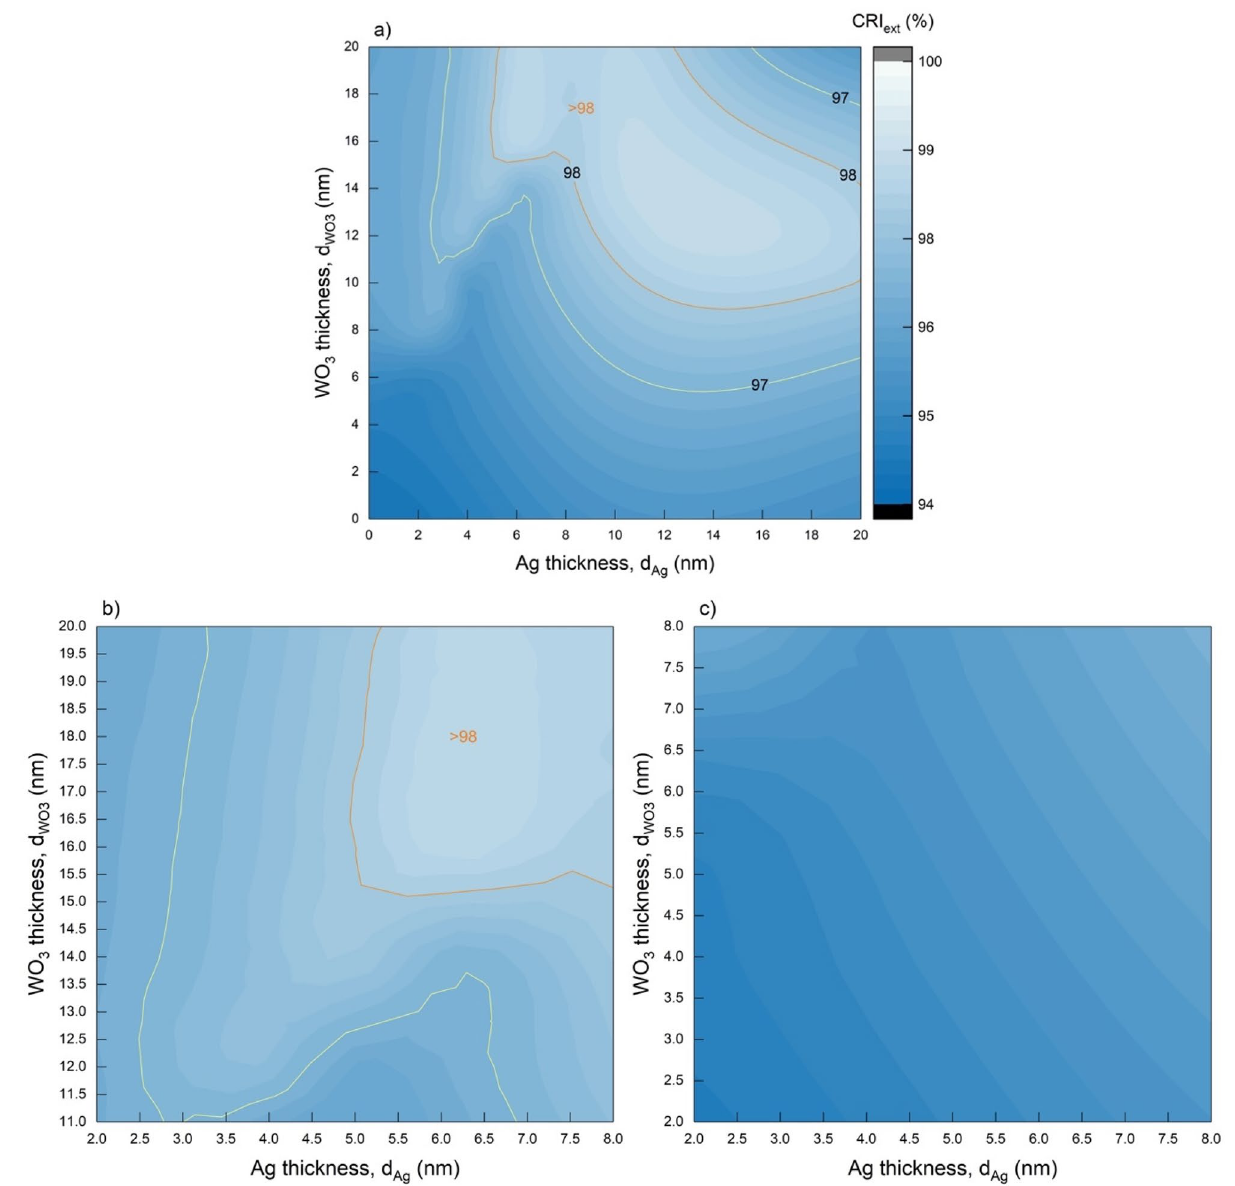
Figure 6. CRI ext mapping of transparent contact structure depending on thickness. Distribution of CRI ext values corresponding to d Ag and d WO 3 for MoO 3 /Ag/WO 3 (10/ d Ag / d WO 3 nm) in the range of ( a ) 0 < d Ag , d WO 3 < 20 nm, ( b ) 11 < d WO 3 < 20 nm and ( c ) 2 < d WO 3 < 8 nm. Areas with orange and yellow straight-line contours contain CRI ext values greater than 98% and 97%,